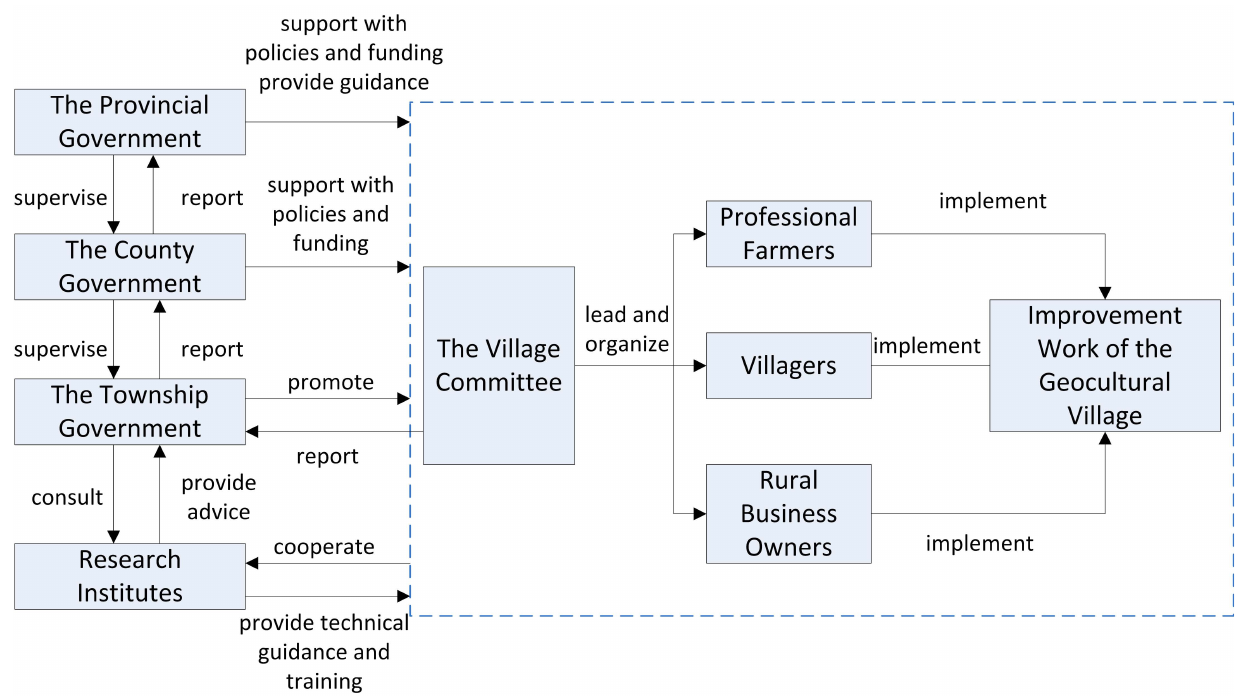
Scheme 3. Relationship between actors in a geocultural